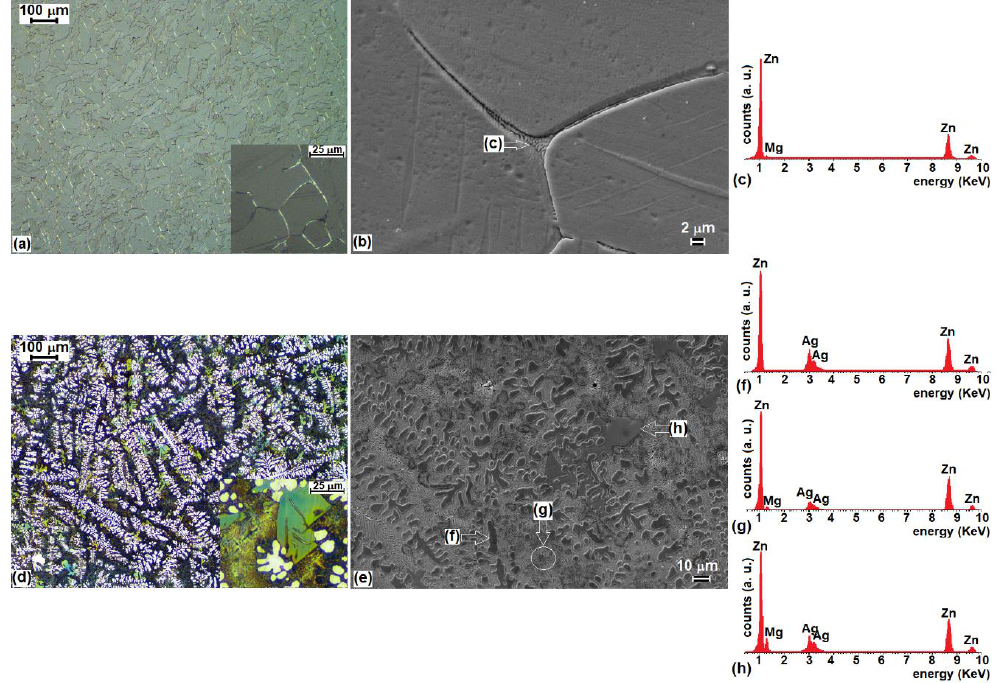
Figure 2. ( a ) Zn–1Mg optical micrograph in the as-cast condition; ( b ) Zn-1Mg SEM micrograph; ( c ) energy dispersive X-ray spectroscopy (EDS) spectrum; ( d ) Zn-12.5Ag-1Mg optical micrograph in the as-cast condition; ( e ) Zn-12.5Ag-1Mg SEM micrograph; ( f – h ) EDS spectrum.